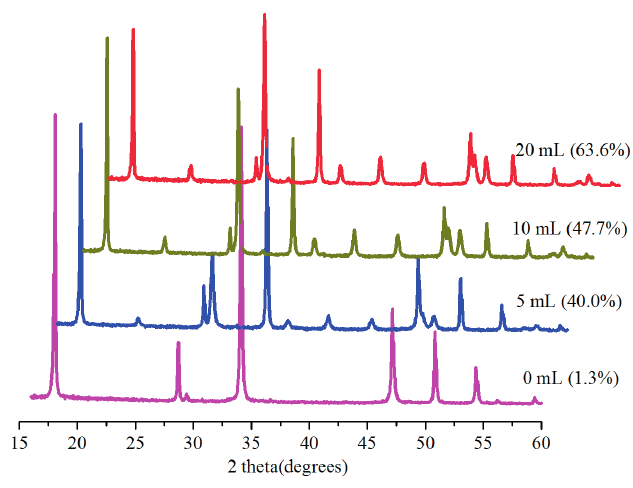
Figure 7. XRD patterns and corresponding conversions (in brackets) for samples produced with the Bmim[Br] and various amounts of water at 0.1 MPa and 30.0 °C in 5 min.